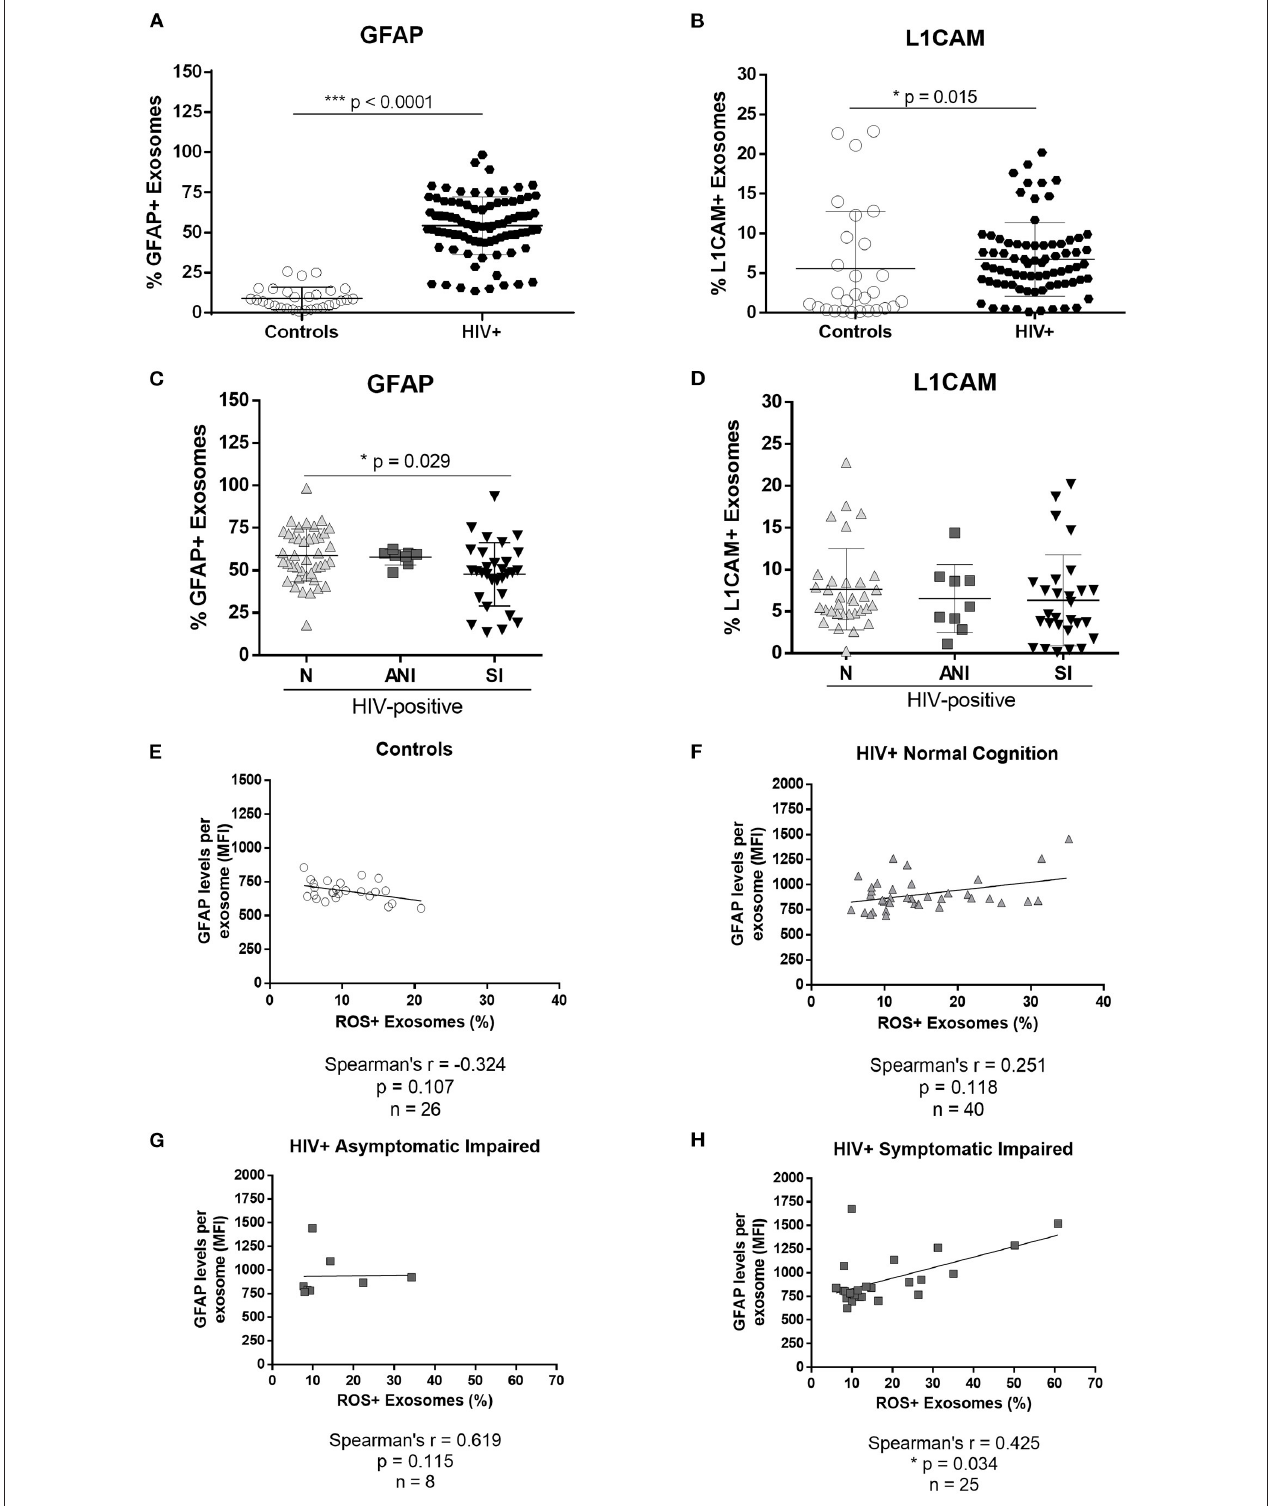
FIGURE 4 | Astrocyte and neuronal markers in plasma-derived exosomes from HIV-infected women. Glial fibrillary acidic protein (GFAP), an astrocyte marker, and L1 cell adhesion molecule protein (L1CAM), a neuronal marker, were measured in plasma-derived exosomes by flow cytometry. Mann–Whitney tests were used to compare GFAP (A) and L1CAM (B) in HIV-negative control subjects and HIV-infected women. There were significant difference in GFAP-infected exosomes (C) levels